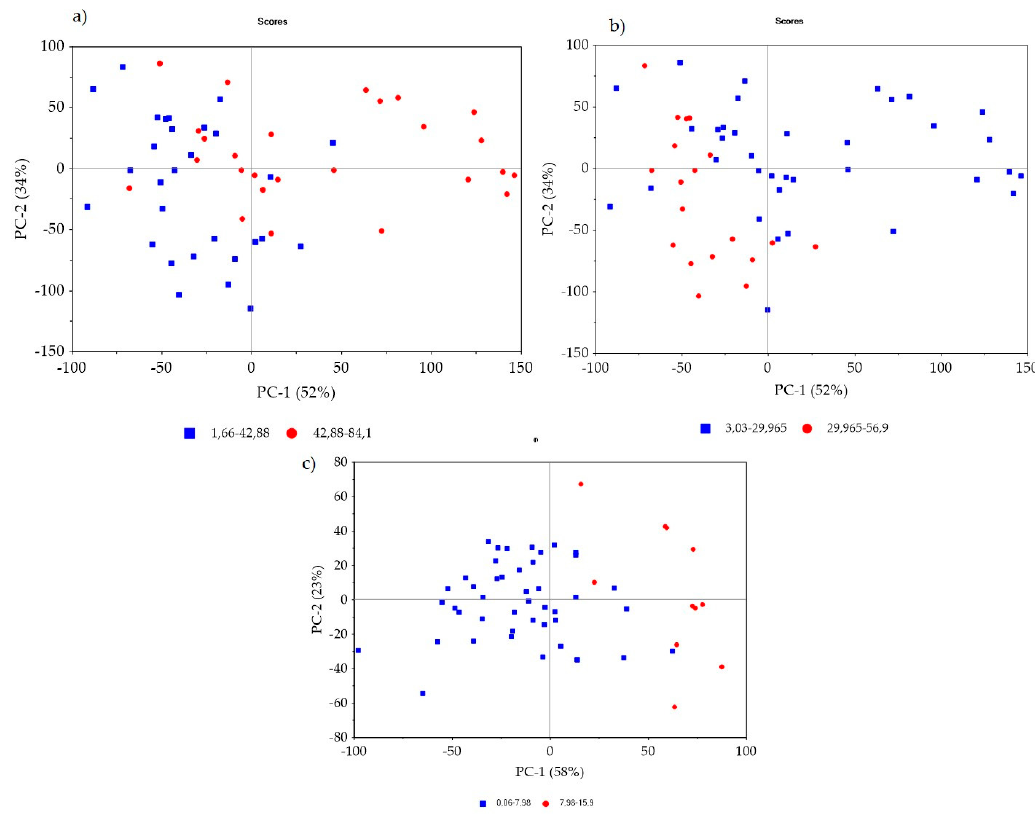
Figure 4. Principal component analysis (PCA) model score plots of ( a ) SiO 2 ; ( b ) Fe 2 O 3 ; and ( c ) Al 2 O 3 concentrations categorized into two ranges (the concentrations are expressed in wt %).